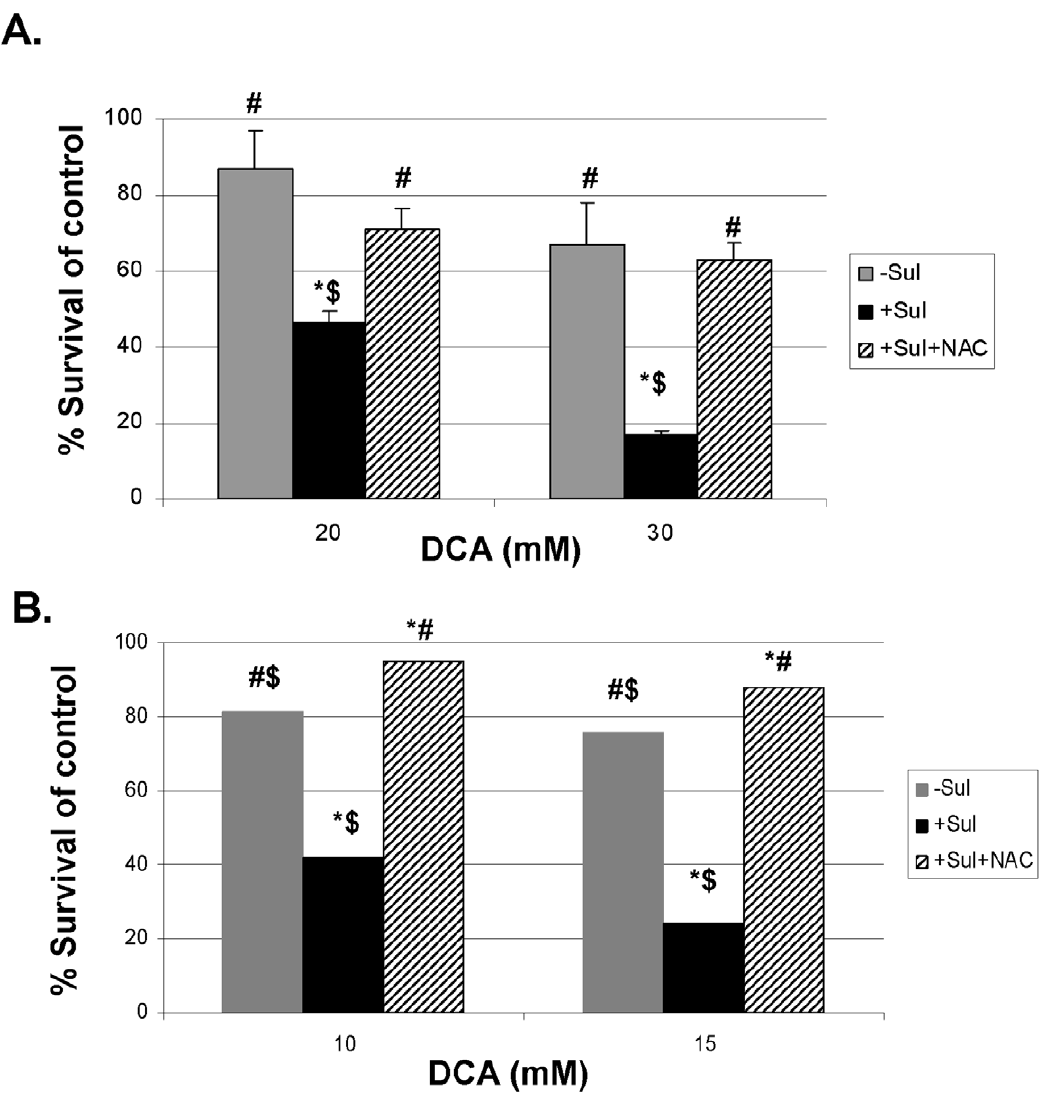
Figure 5. The ROS scavenger NAC reverses the killing of cancer cells by the combination of sulindac and DCA. The A549 and SCC25 cancer cells were treated with the indicated concentrations of DCA in the absence (grey bar) or presence of sulindac (black bar) or presence of sulindac and N-acetylcysteine (striped bar) for 48 hours. The cell viability was monitored by MTS assay as mentioned in the Methods. The cell viability is expressed as % of control (cells not treated with sulindac). Error bars are standard error of the mean (SEM) expressed as % of the mean value of quadruplicates from a representative experiment. Inhibition of cancer cell growth occurred in a dose dependent manner during combination treatment of DCA and sulindac (black bars) in both A549 cancer (A) and SCC25 cancer cells (B). However, this enhanced killing was prevented when N-acetylcysteine was present with the drug combination treatment (striped bars in A and B).